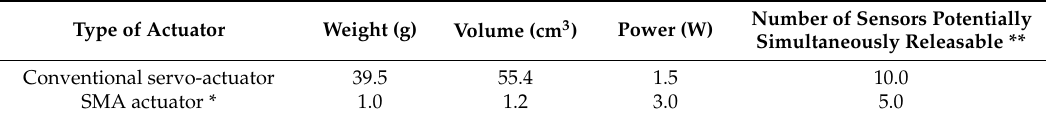
Table 6. Performance comparison with a conventional